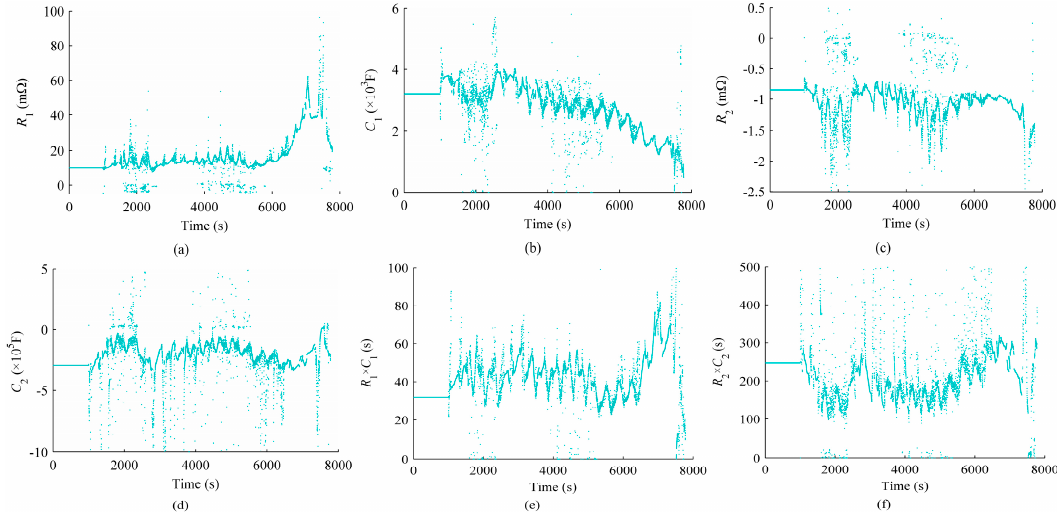
Figure 13. Identified ( a ) R 1 ; ( b ) C 1 ; ( c ) R 2 ; ( d ) C 2 ; ( e ) R 1 ˆ C 1 and ( f ) R 2 ˆ C 2 under